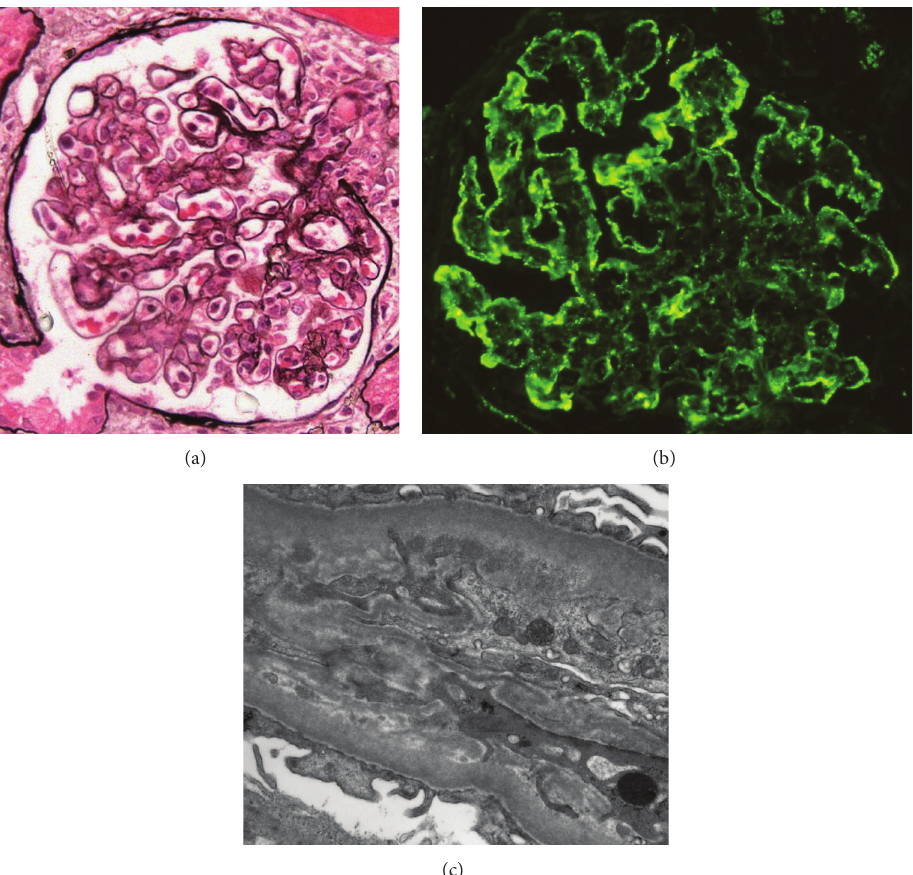
Figure 1: Glomerular renal biopsy findings. (a) Mesangial and endocapillary hypercellularity with a lobular pattern and segmental capillary double contours (periodic acid methenamine silver × 400). (b) Peripheral granular staining for C3 ( × 400). (c) Capillary wall subendothelial electron dense deposits with peripheral mesangial migration and new subendothelial basement membrane material forming a double contour ( ×